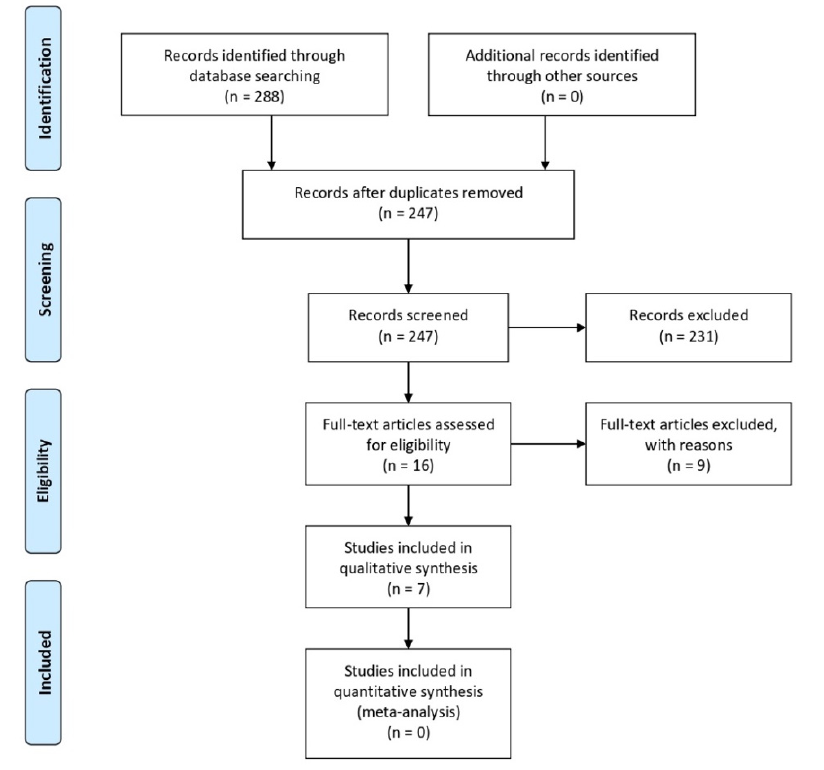
Figure 1. Flow diagram according to the PRISMA guidelines summarizing the systematic screening process.